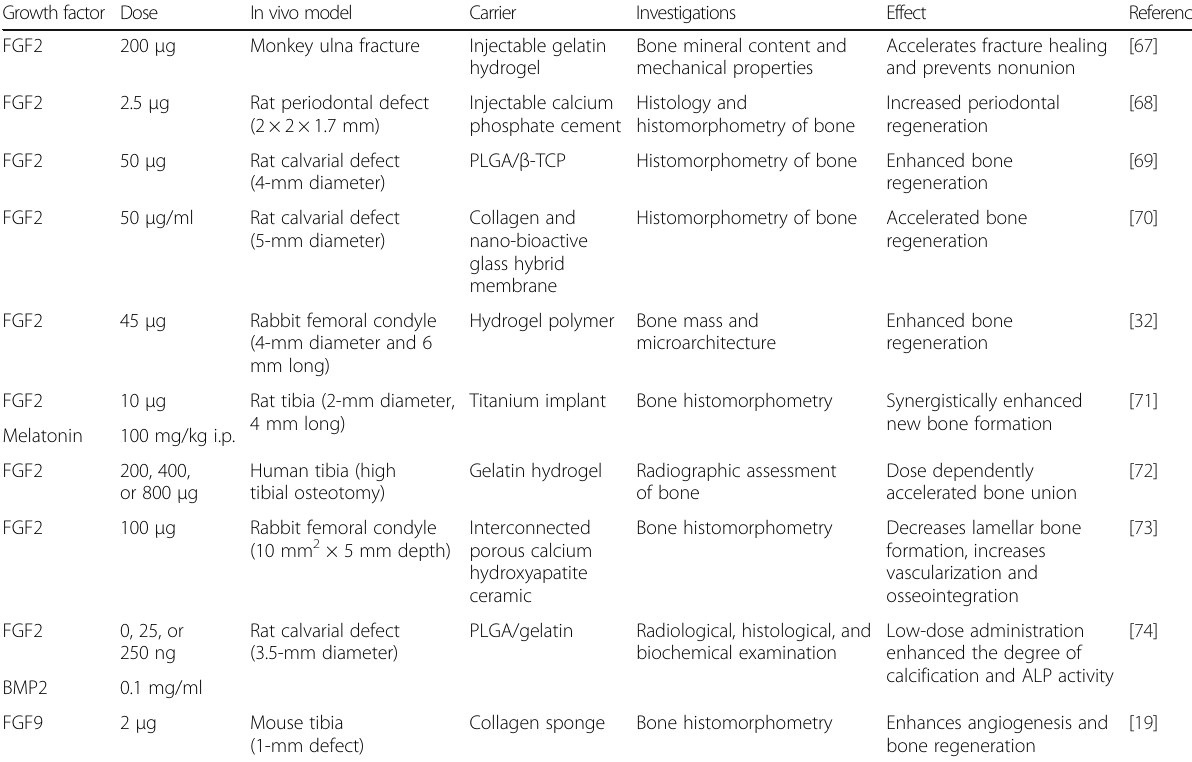
Table 2 Application of different FGFs in non-critical-sized bone defect in vivo models Growth factor Dose